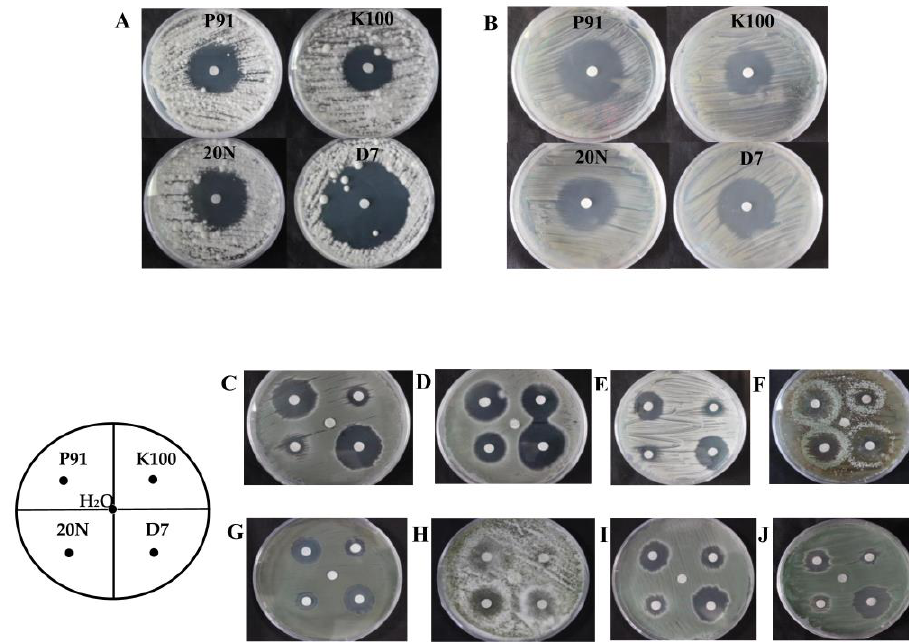
Figure 5. Sensitivity of fungal isolates to four biocides. The suppression halo around the paper shows the effectiveness of the biocide against the fungal strain isolates. All fungal isolates were cultured at 28 °C for 2 d. ( A ) NKDMZ-1. ( B ) NKDMZ-13. ( C ) NKDMZ-2. ( D ) NKDMZ-3. ( E ) NKDMZ-10. ( F ) NKDMZ-14. ( G ) NKDMZ-15. ( H ) NKDMZ-16. ( I ) NK-NH3(MH392741.1). ( J ) TJM-F5